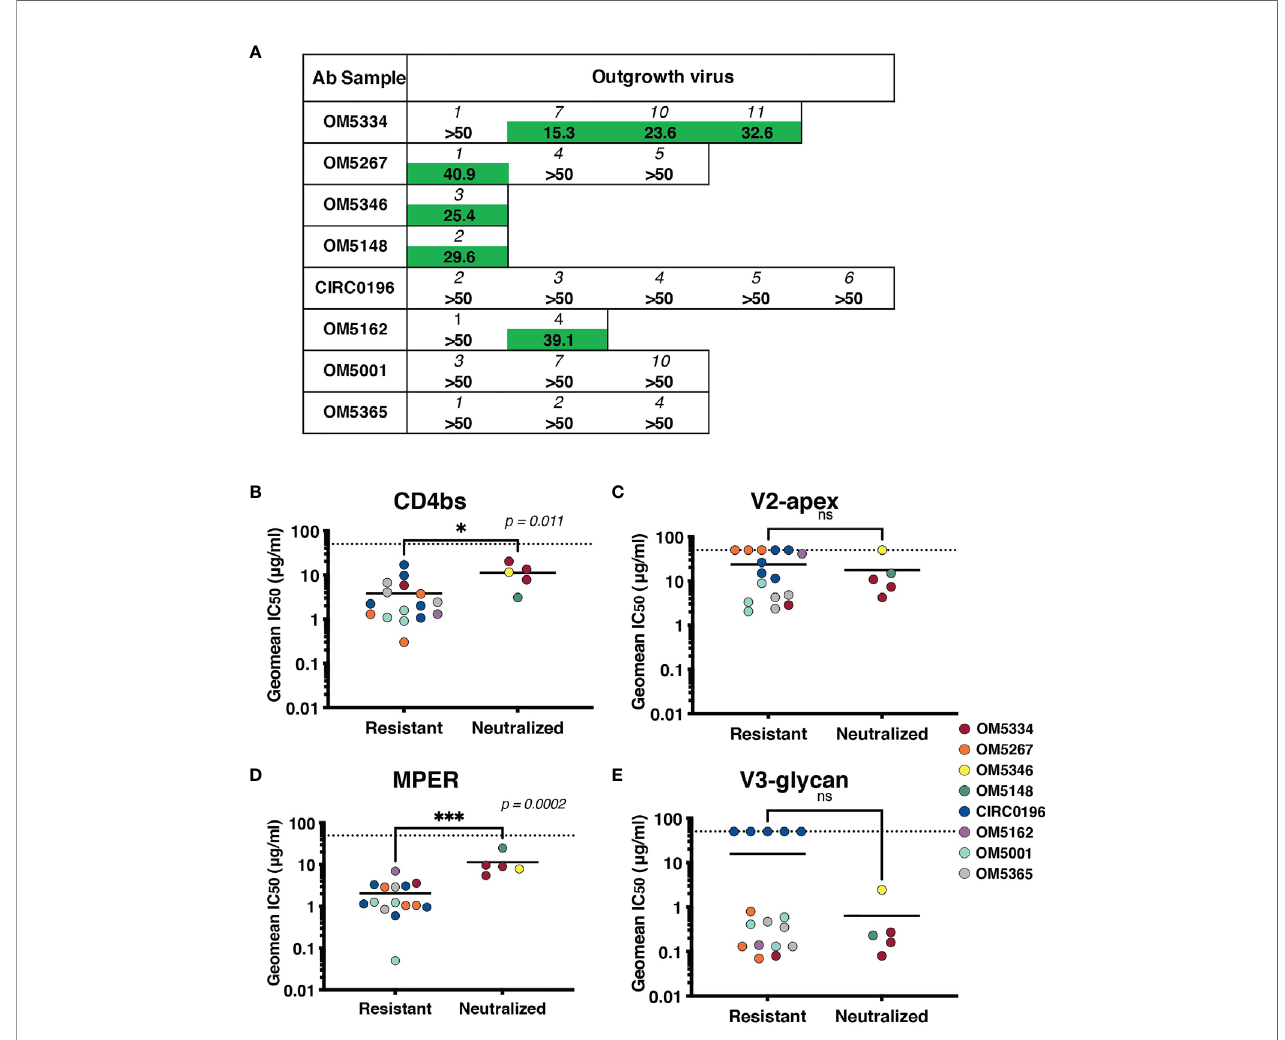
FIGURE 5 | Sensitivity of the inducible reservoir to autologous IgG and to bNAbs targeting multiple epitopes. (A) IC 50 values for each individual ’ s IgG against autologous QVOA-derived viruses. Viruses resistant at 50µg/mL of IgG were denoted with “ >50 ” . (B – E) Geometric mean IC 50 s of bNAbs were calculated for viruses resistant to autologous neutralization (IC 50 >35µg/mL) and those that were sensitive. IC 50 s were graphed by epitope targeted: (B) CD4bs antibodies include VRC01, VRC07-523, 3BNC117, and N6, (C) V2-apex antibodies include PGDM1400, CAP256.VRC26.25, and PG09, (D) MPER antibody 10E8v4-V5F-100cF, and (E) V3-glycan antibodies include PGT121 and 10-1074. Geometric mean IC 50 s are color-coded by individual, and the limit of detection (50 m g/ml) is indicated with a dotted line. * signi fi es p < 0.05. *** signi fi es p < 0.001. ns signi fi es p >